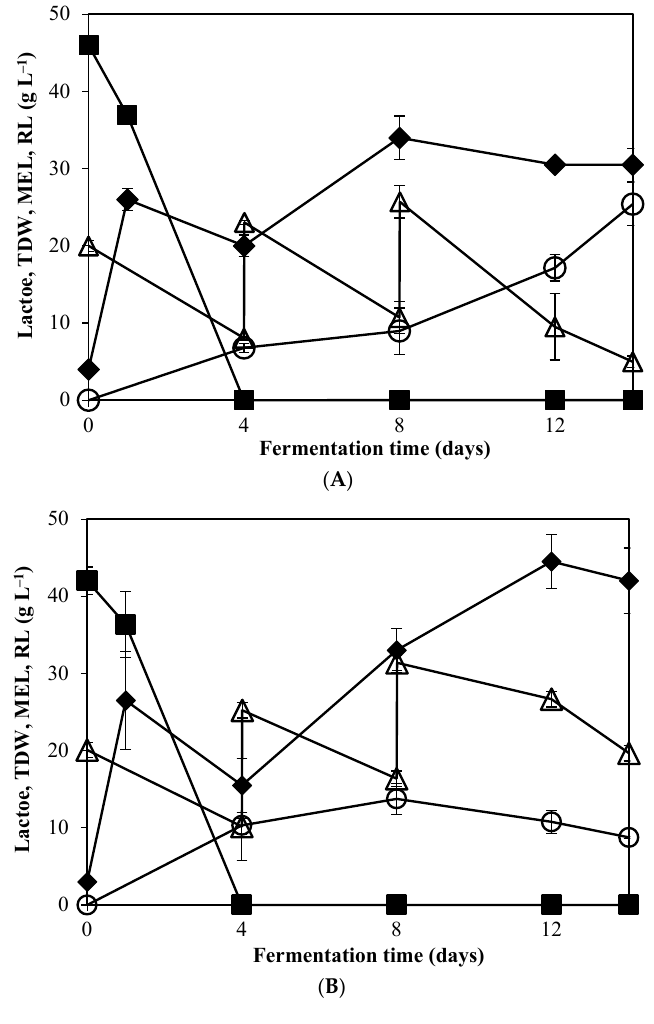
Figure 2. Profile change of ( ○ ) MEL, ( ■ ) lactose, ( △ ) residual lipids (RL), and ( ◆ )total dry weight (TDW) during fermentation of M . antarcticus on supplemented CWP with yeast extract and NaNO 3 ( A ) and CWP without any supplementation ( B ).